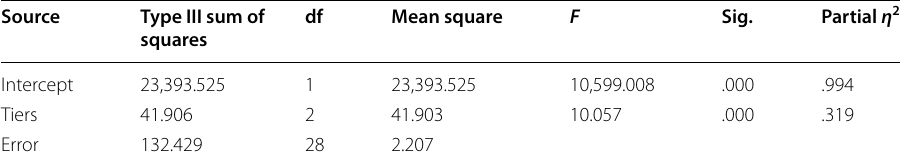
Table 8 Multivariate tests of within-subjects effect in individual group Source Type III sum of df Mean square F Sig. Partial η 2 squares Intercept 23,393.525 1 23,393.525 10,599.008 .000 .994 Tiers 41.906 2 41.903 10.057 .000 .319 Error 132.429 28